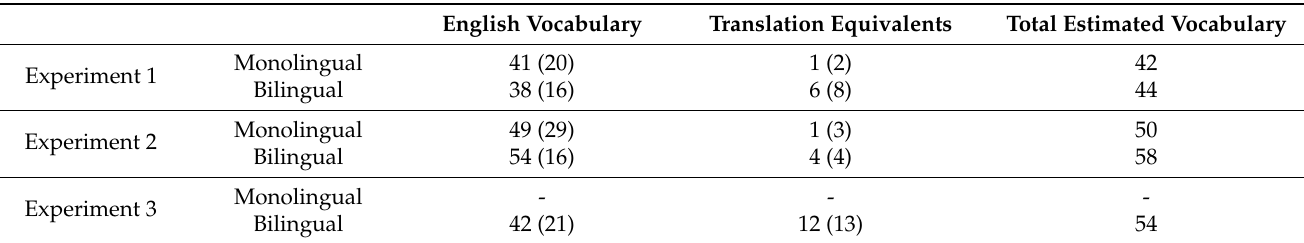
Table 2. Descriptive statistics for the CDI (Communicative Development Inventory) information for all experiments. The values represent the Average Total English Vocabulary (standard deviation), Average Translation Equivalents 1 , and Average Total Estimated Vocabulary in Both Languages (English Vocabulary + Translation